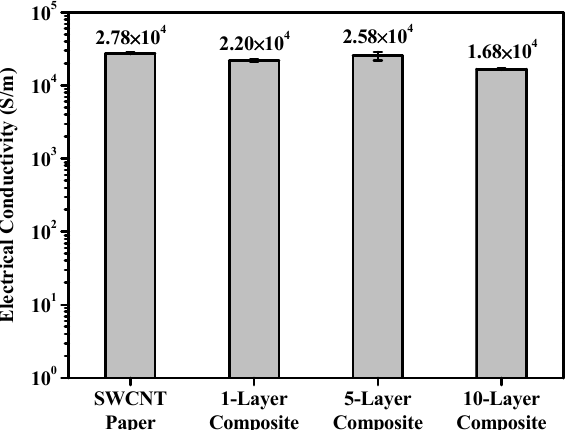
Figure 4. TGA plots of epoxy film, SWCNT paper, and SWCNT/epoxy composite; ‘x’ and ‘y’ are what remains after epoxy film and SWCNT/epoxy composite were burned, respectively.